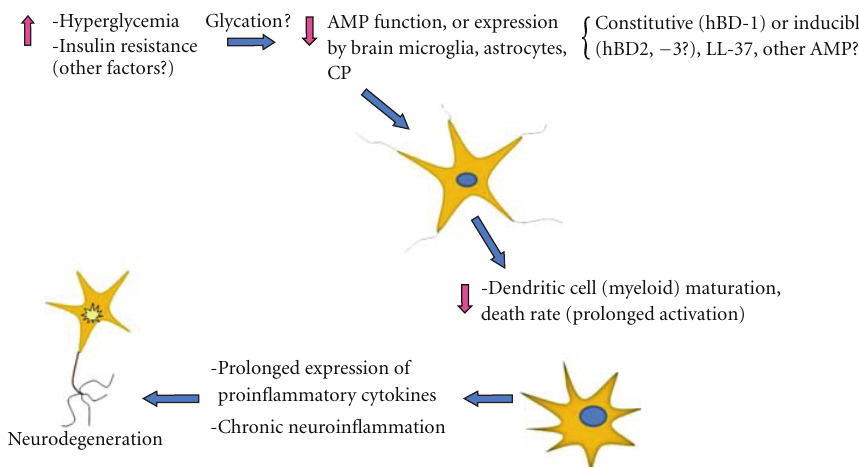
Figure 1: It is hypothesized that reduction or abnormal elevation of AMP expression by brain microglia, astrocytes, or choroid plexus epithelium (CP) may contribute to loss of AMP-induced regulation of dendritic cell maturation and activity. Prolonged and elevated dendritic cell activity could in turn contribute to chronic release of proinflammatory cytokines (IL-6, IL-8, etc.) that ultimately promote neuronal cell injury and death. Hyperglycemia-induced glycation of specific AMPs may inhibit antimicrobial and immunomodulatory